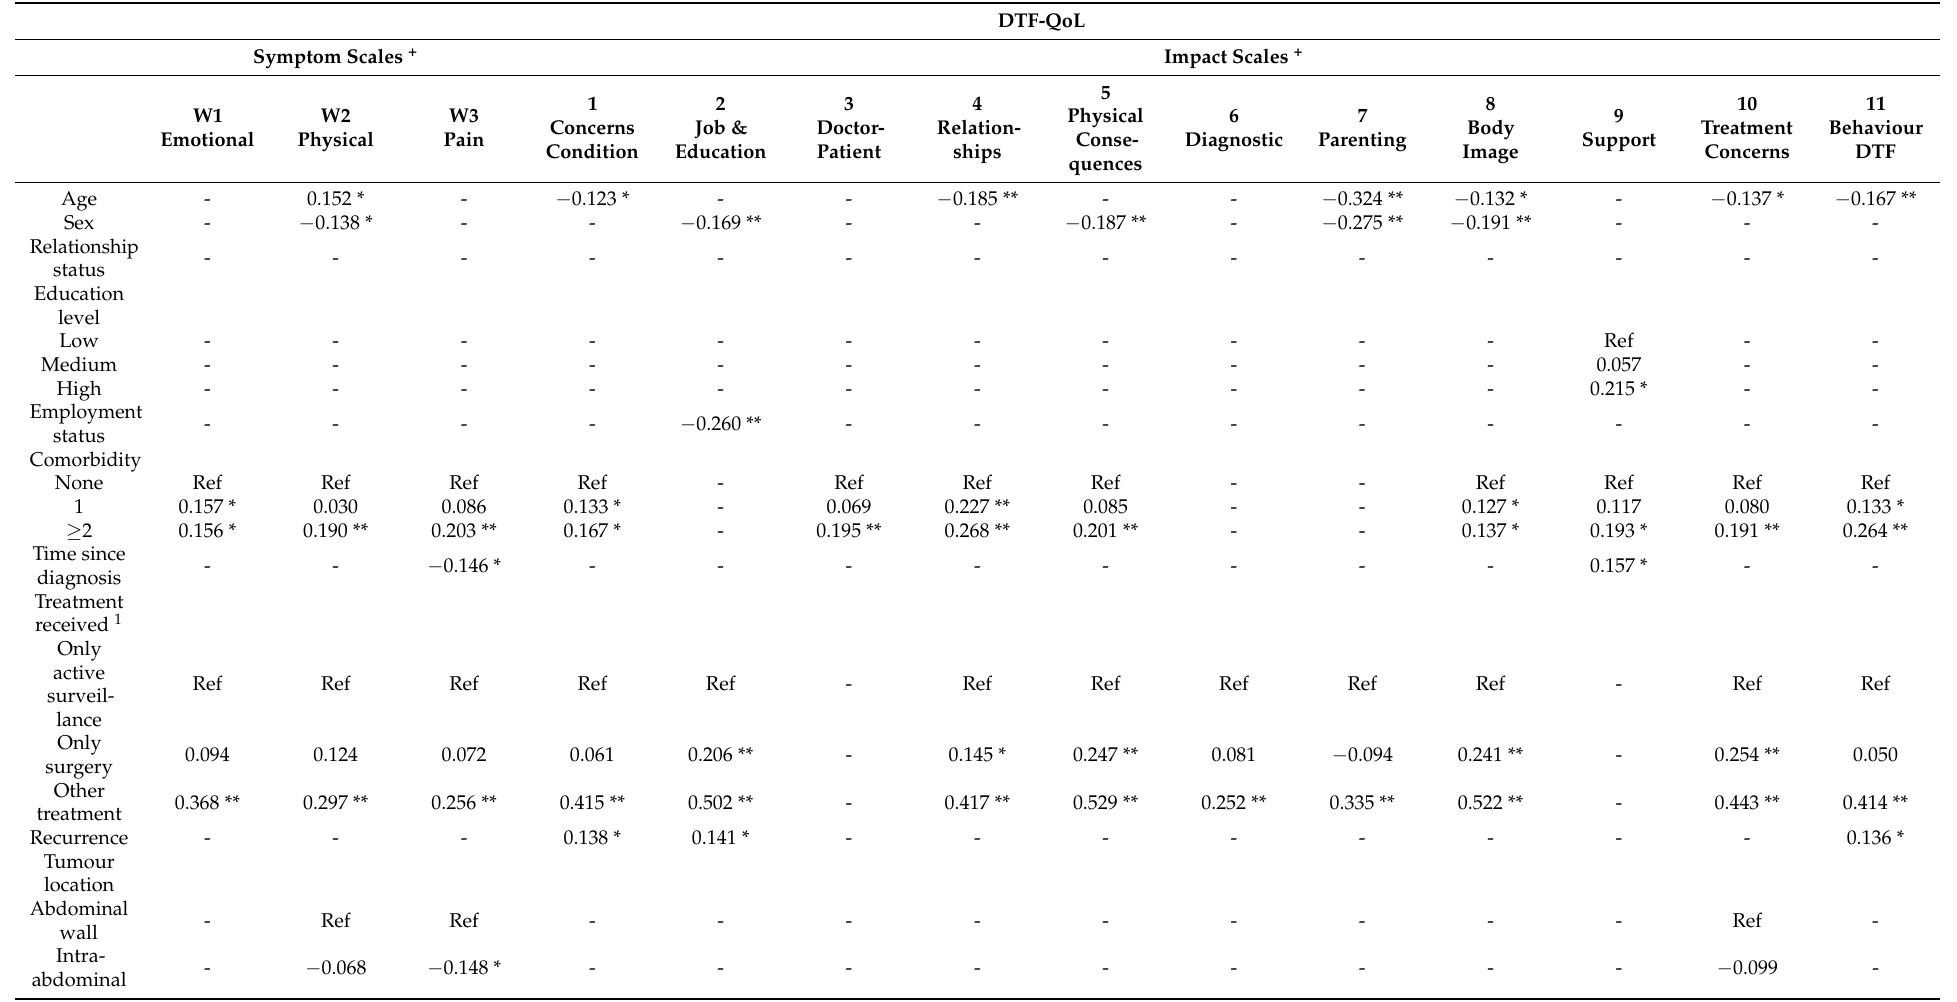
Table 4. Standardised betas of multiple linear regression models evaluating the association of independent variables ( p < 0.05) with the DTF-QoL, using backward